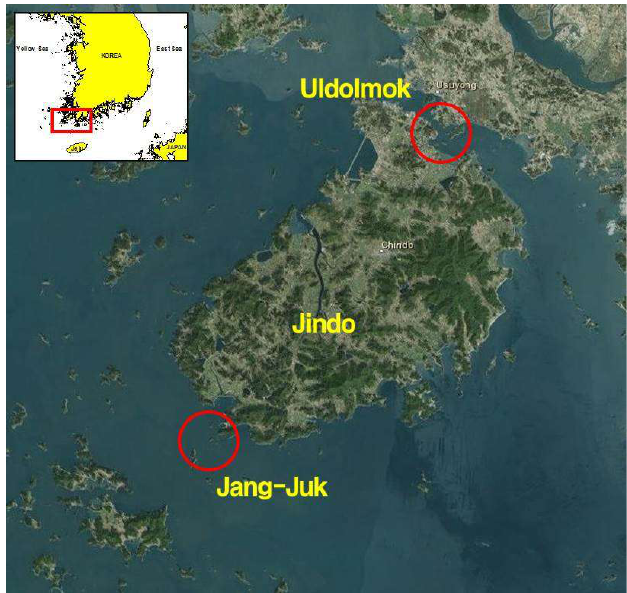
Figure 6. A Map showing locations of Uldolmok and Jang-Juk Straits.